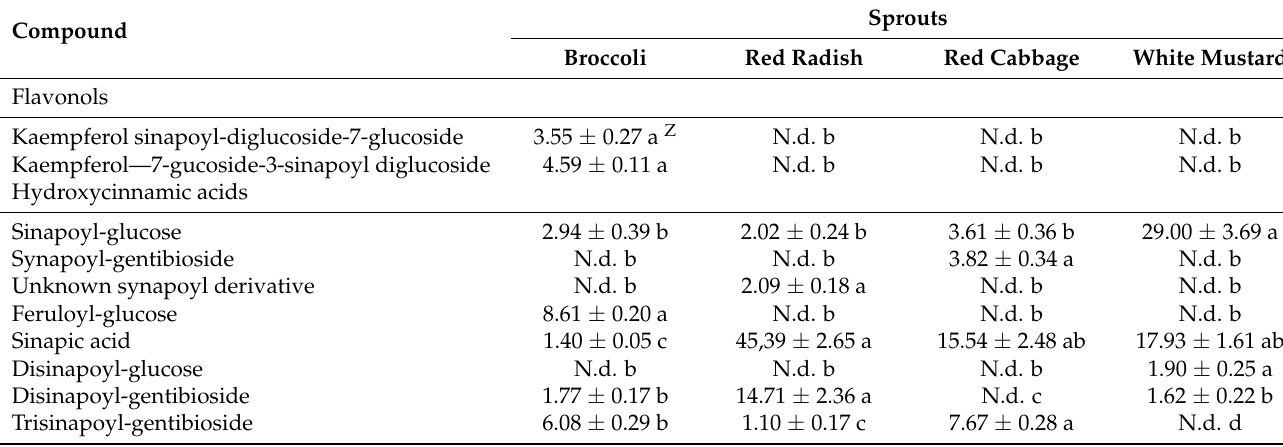
Table 4. Quantitative profile (mg/100 g fw) of individual flavonols and hydroxycinnamic acids of the products of the gastrointestinal digestion of cruciferous